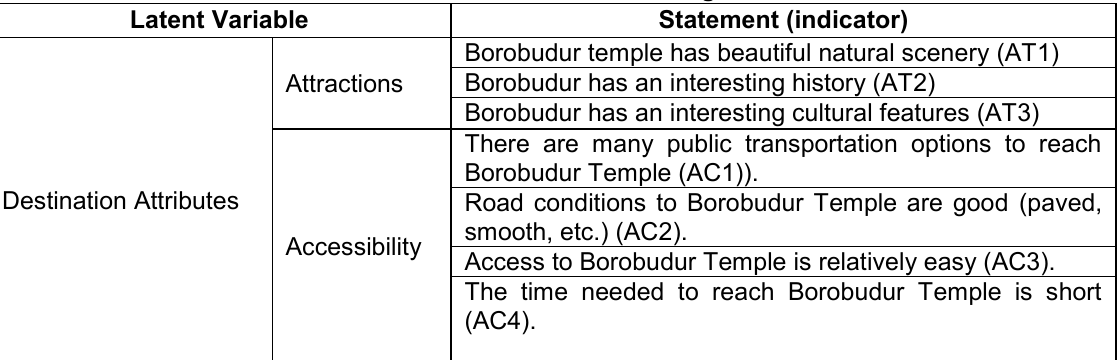
Table 1: Questionnaire